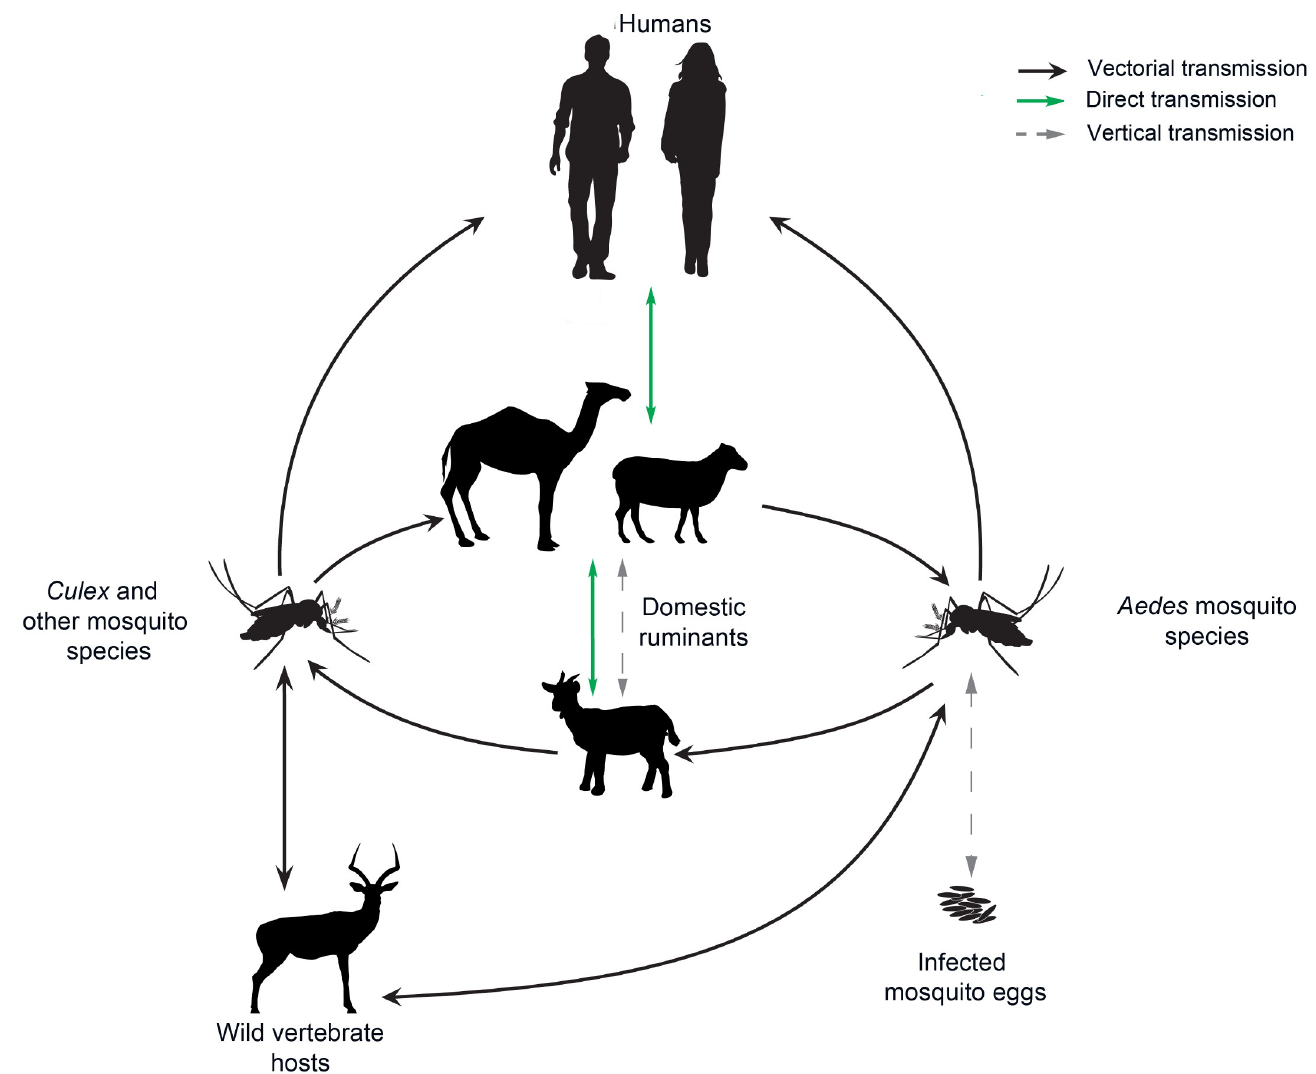
Fig 4. Epidemiological cycle of Rift Valley fever virus. The figure is adapted from [119] .